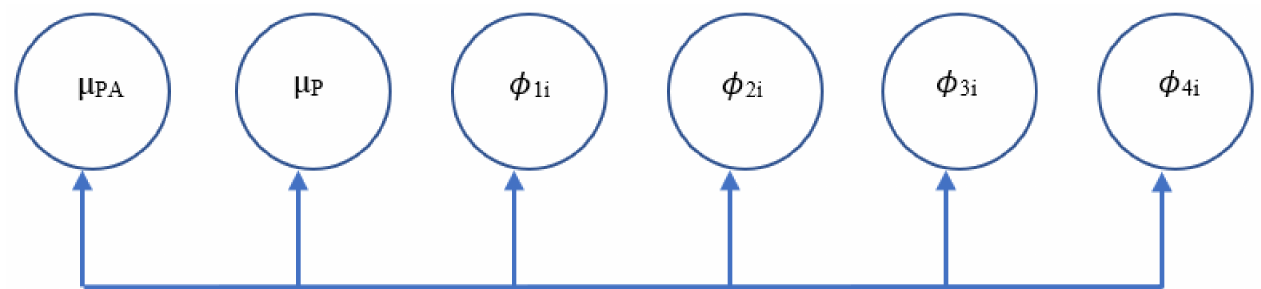
Figure 2. VAR(1) Model: Within-Person. Note. Figure 2 depicts the within-person components of the study model. T represents time point, t − 1 represents previous time point, φ represents autoregressive parameters (how quickly an individual restores to equilibrium) and cross-lagged regression effect (predictive relationships/spill-over), PA represents physical activity, P represents pain, and ζ represents dynamic errors.